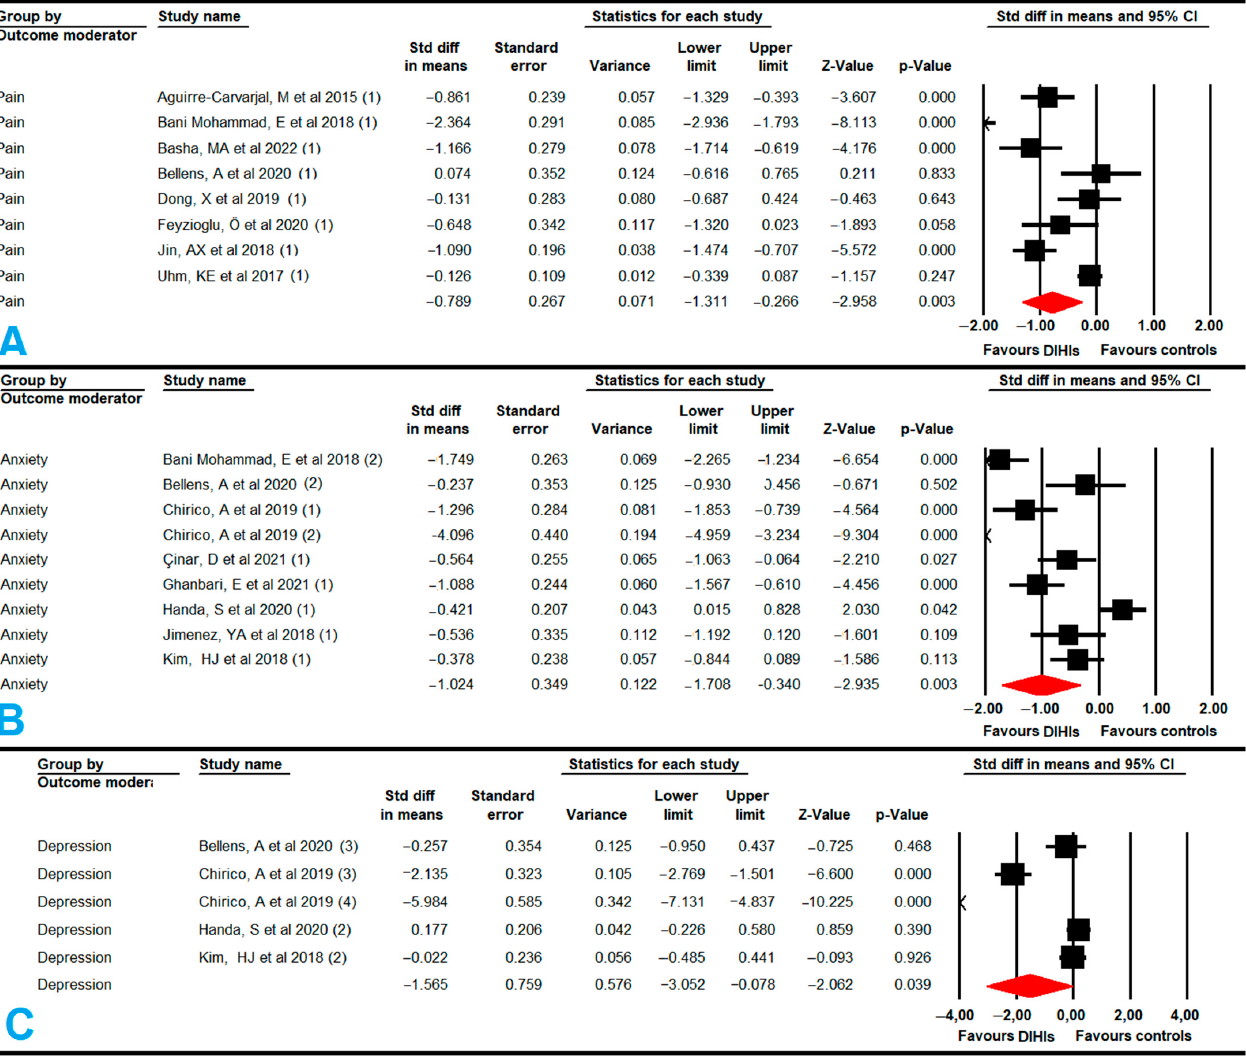
Figure 5. Forest plot of the effect of digital and interactive health interventions on pain ( A ), anxiety ( B ), and depression ( C ) [55,57–59,61,65,67–70,72–74]. Subgroup analyses found that non-immersive and immersive VRBT [55,59,67–69,73] produced a large effect in terms of reducing pain (SMD, − 1.03; 95% CI: − 1.52, − 0.54; p < 0.001) in comparison with conventional therapy or care. Pain was able to be reduced by 3.83 points (95% CI: − 5.88, − 0.9; p = 0.008) when VRBT was used. However, no statistically significant differences were found between SABT and conventional training (SMD, − 0.13; 95% CI: − 0.94, 0.68; p = 0.756), although this finding must be considered with caution due to the low number of studies that provided data [65,72]. 3.5.7. Anxiety Eight studies [57,58,61,67,69–71,74] with eight independent comparisons provided data from 660 participants (73 per study) to assess the effect of DIHIs on reducing anxiety. Low-quality evidence of a large effect (SMD, − 1.02; 95% CI: − 1.71, − 0.34; p = 0.003) favored DIHIs in comparison to conventional therapy (Figure 5, Table 4). The risk of publication bias (asymmetric funnel plot; Egger p = 0.02; 32% variation after trim-and-fill estimation (adjusted SMD, − 1.35)) (Supplementary Figure S7) and heterogeneity were moderate (I 2 =